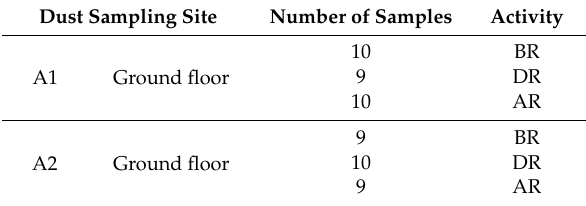
Table 1. Characterization of dust sampling sites, number of measurements, and designation of activities of asbestos–cement product (ACPs) removal (before removal—BR; during removal—DR; after